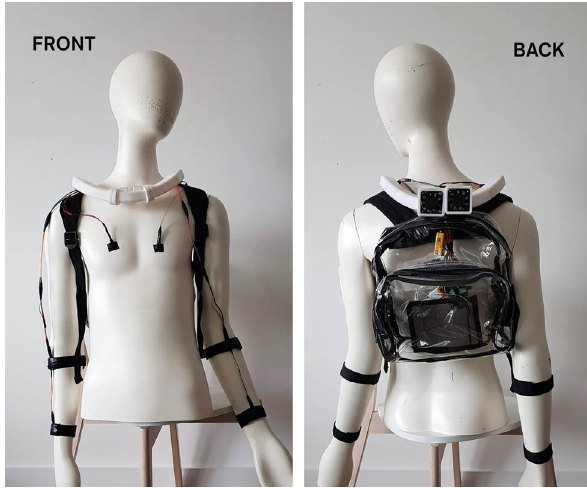
Figure 2: Photograph of a wearable device designed for the experiment.